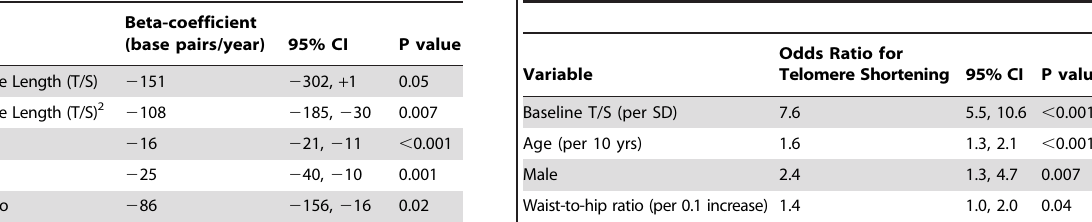
Table 3. Independent predictors of leukocyte telomere shortening as a dichotomous variable (multivariable logistic regression with backward selection of candidates in table 1 retained at p ,